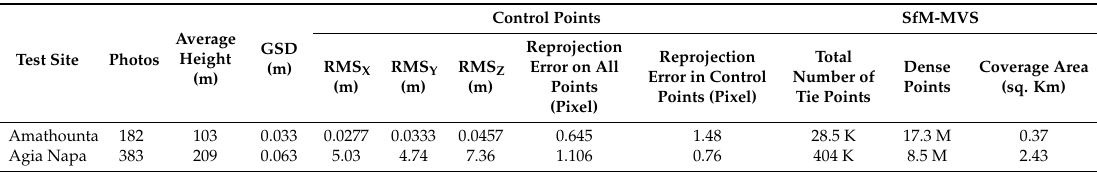
Figure 13. Agia Napa test site: camera locations and photo overlap ( left ) and reconstructed digital elevation model ( right ). Table 1. Flight and photo ‐ based processing details regarding the two different test sites.